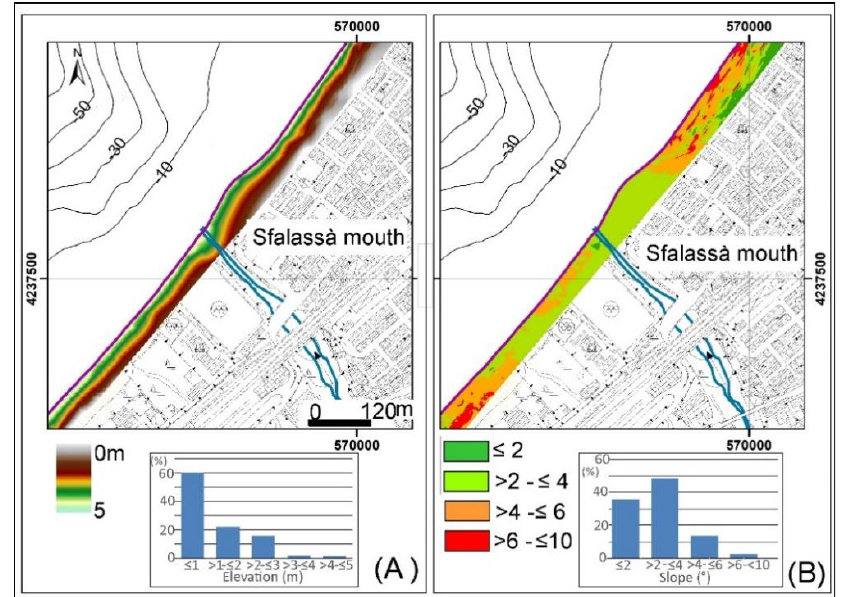
Figure 12. The maps show the spatial distribution of elevation ( A ) and slope ( B ) data. The bar graphs indicate the percentage of emerged beaches characterised by specific elevation and slope values. Source: own elaboration overlaid to the Technical Map of Calabria Region.